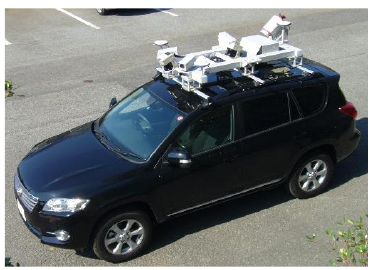
Figure 1. Mobile mapping system